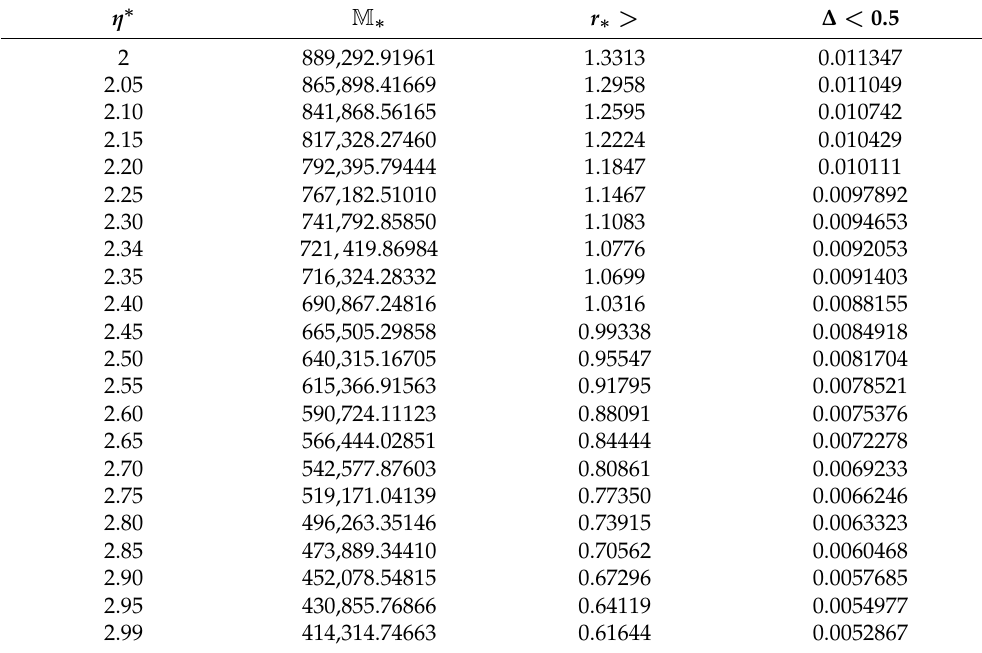
Table 1. Numerical values for M ∗ ,min r ∗ and ∆ corresponding to different values of order η ∗